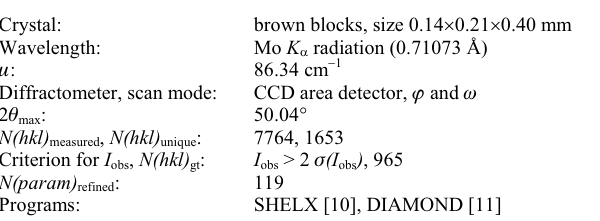
Table 1. Data collection and handling.